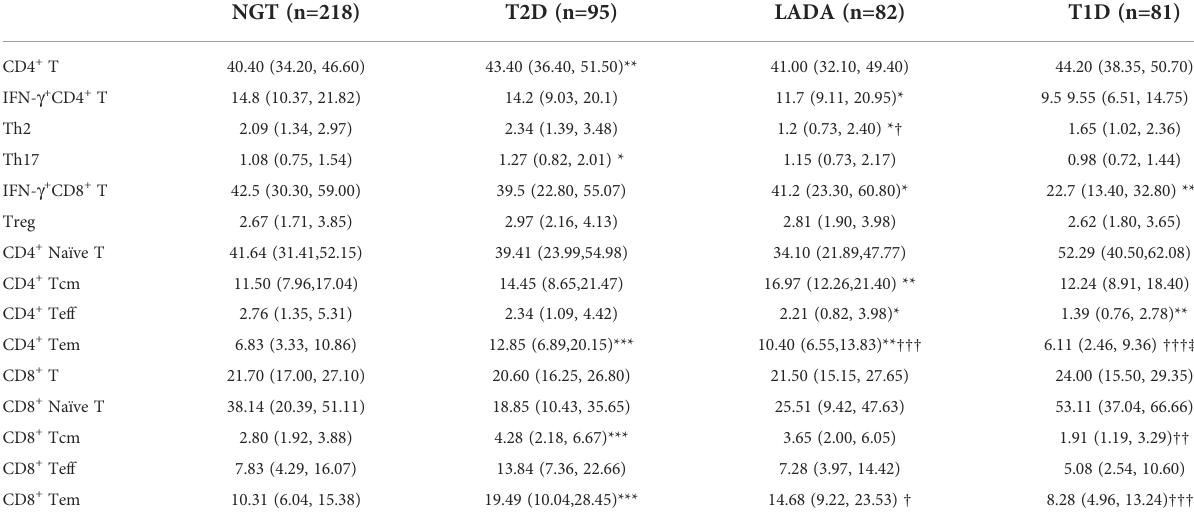
TABLE 2 T-cell subset frequencies in diabetic patients and NGT subjects.